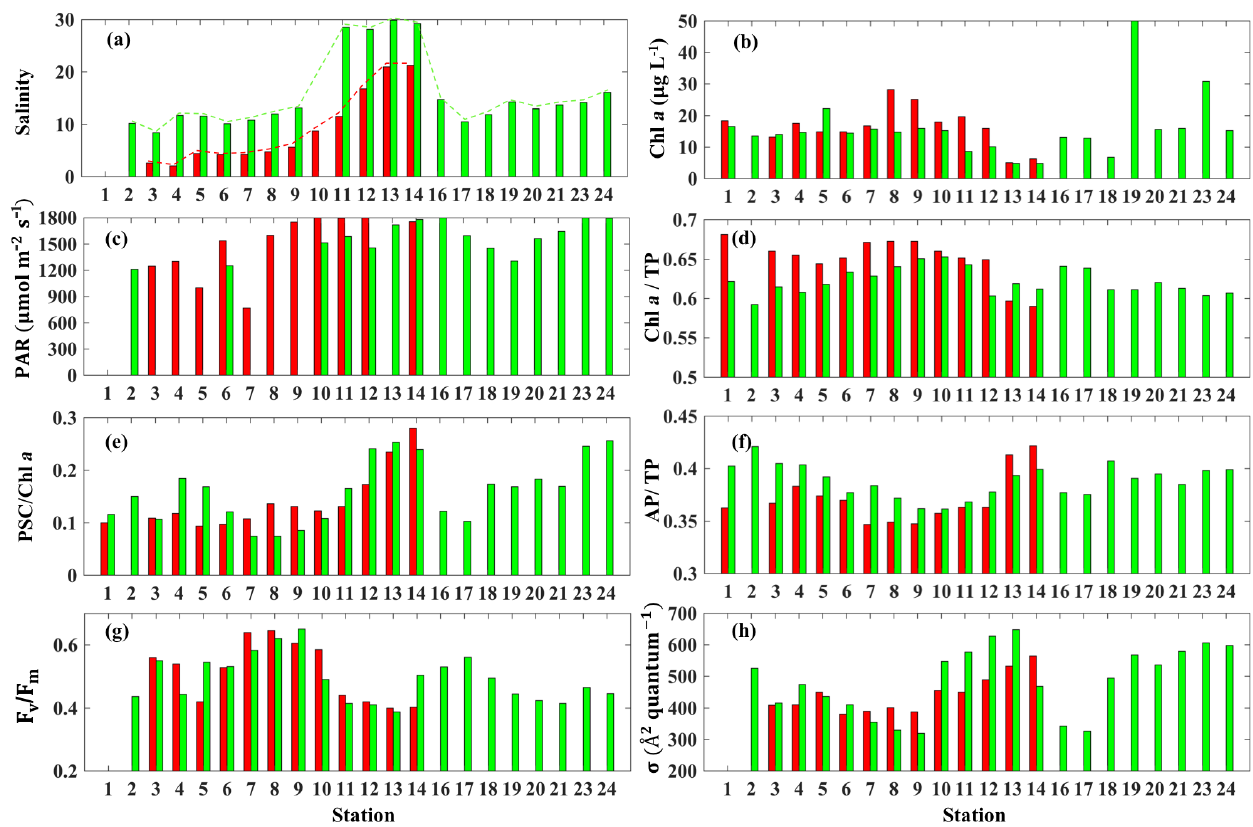
Figure 7. Environmental conditions (salinity, light field), pigment composition and physiological state in GB surface waters (red bars indicat- ing samples from 29 September 2017 and blue bars representing samples from 29 and 30 October 2017). (a) Salinity, (b) Chl a concentration, (c) PAR, (d) Chl a / TP, (e) PSC / Chl a , (f) AP / TP, (g) F v /F m and (h) σ PSII